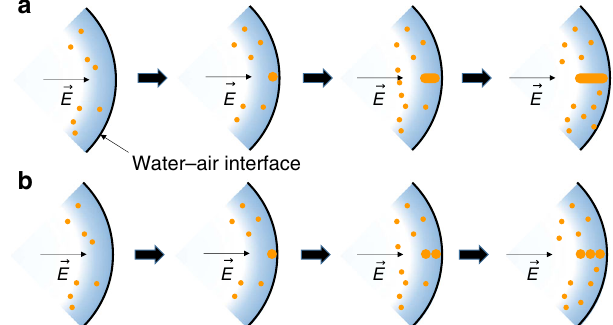
Fig. 6 Possible mechanism for nanowire growth in the microdroplets. a AuNW formation by the growth of an initial seed at the surface of the microdroplet. b AuNW grown by the self-assembly